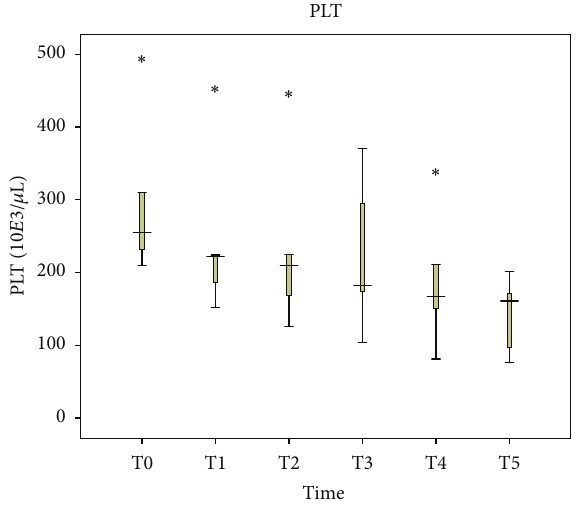
to the multiple organ failure syndrome (MOFS) and often ending with